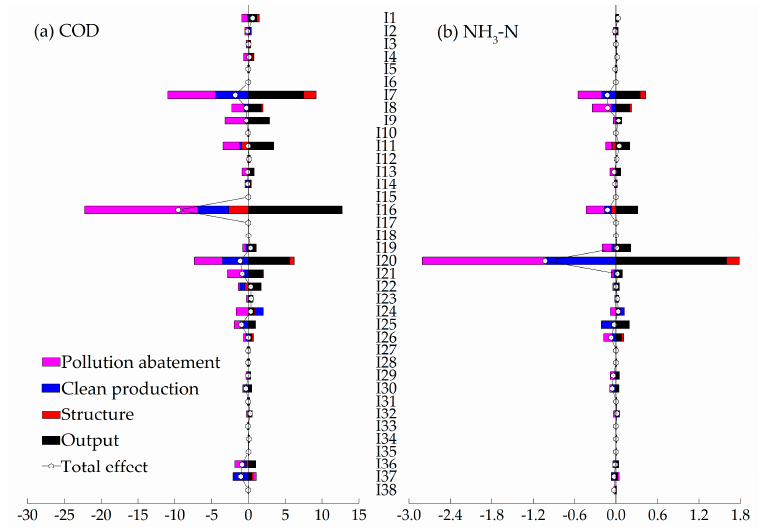
Figure 5. The contributions of the four effects and the corresponding total effect on the two discharges from all 38 sub-sectors during the period 2003–2014 (10 4 t). ( a ) COD and ( b ) NH 3 -N. Table 3. The top ten sub-sectors contributing to COD discharge by their different effects (10 4 t). No.